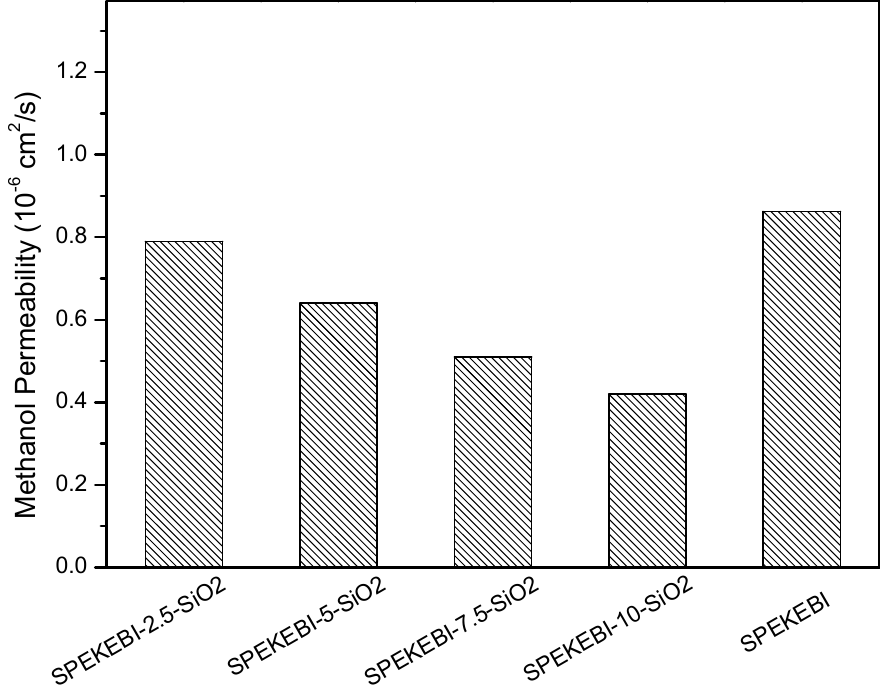
Figure 10. Methanol permeability of SPEKEBI-x-SiO 2 and SPEKEBI membranes. Table 2. Selectivity of SPEKEBI-x-SiO 2 and SPEKEBI membranes.